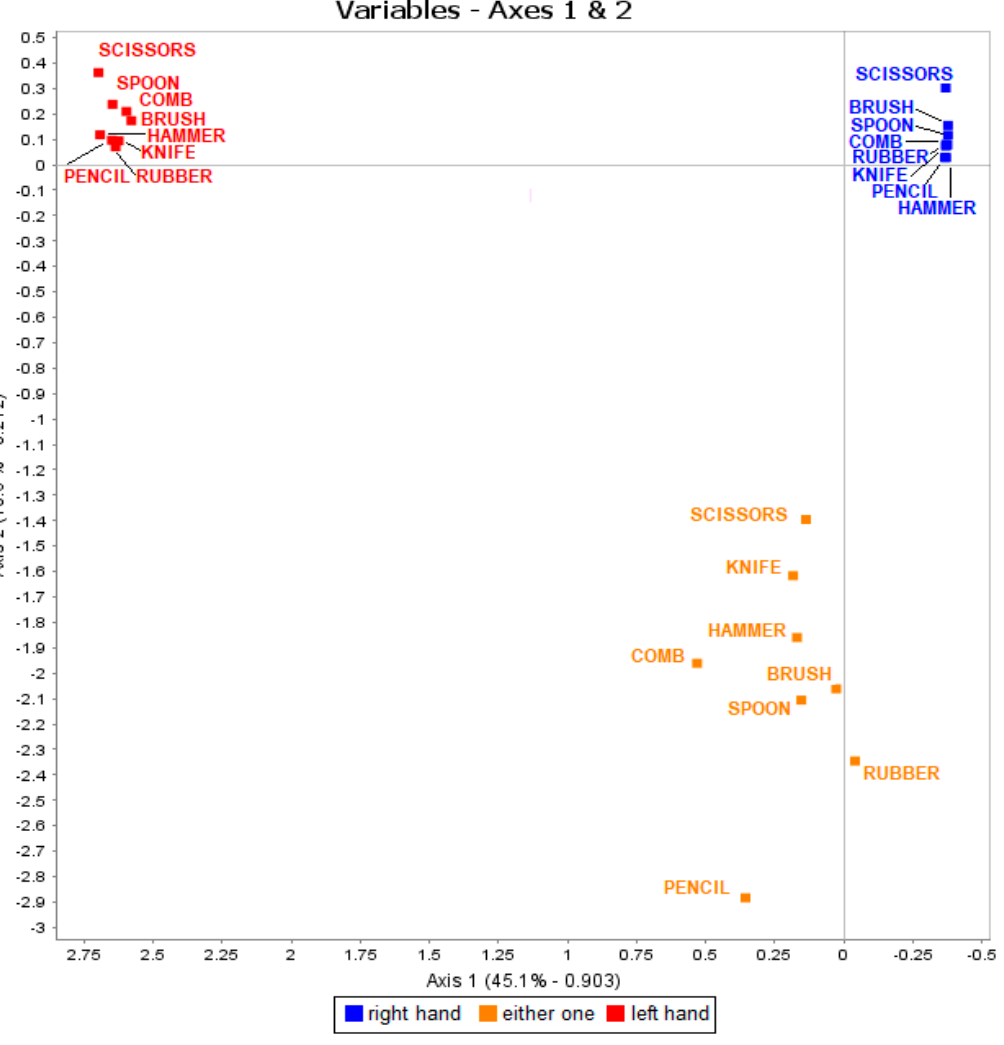
Figure 2. Distribution of Responses to the 8-item Hand Preference Test as a function of hand at 5.